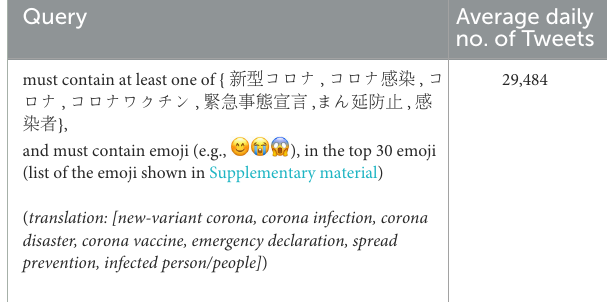
FIGURE1 General illustration of our framework.